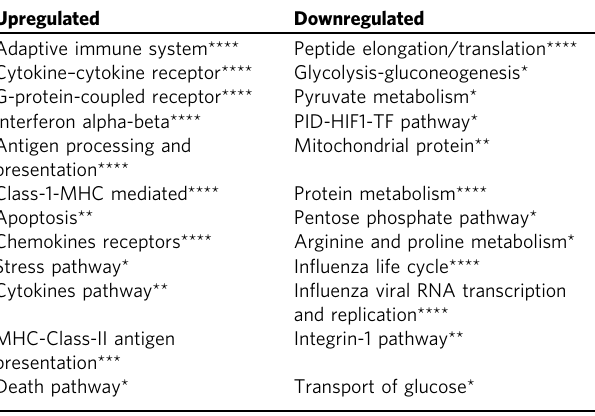
Table 2 Pathways upregulated and downregulated by A3A in M1-polarized